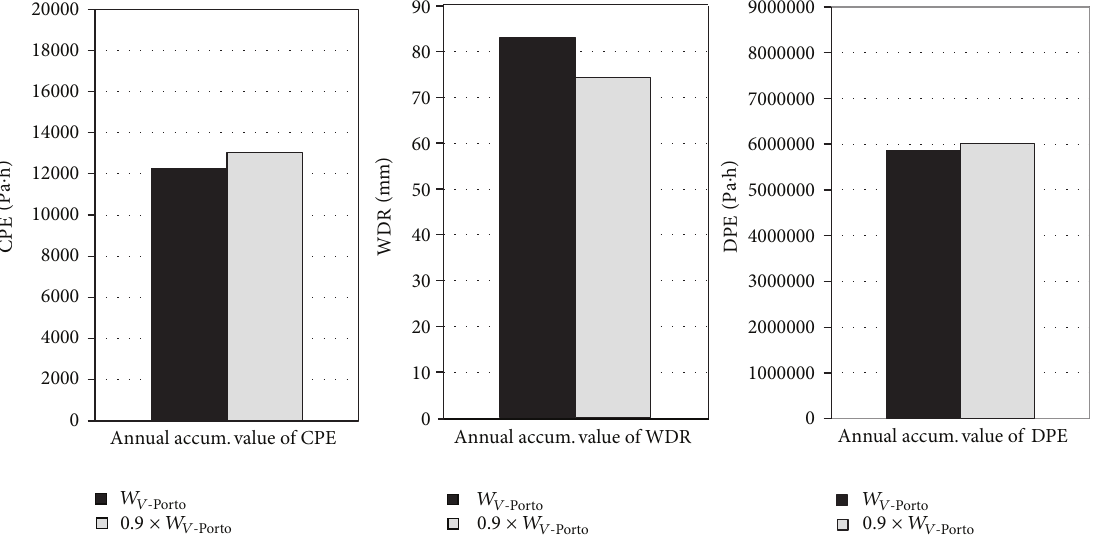
Figure 20: Exterior climate: wind